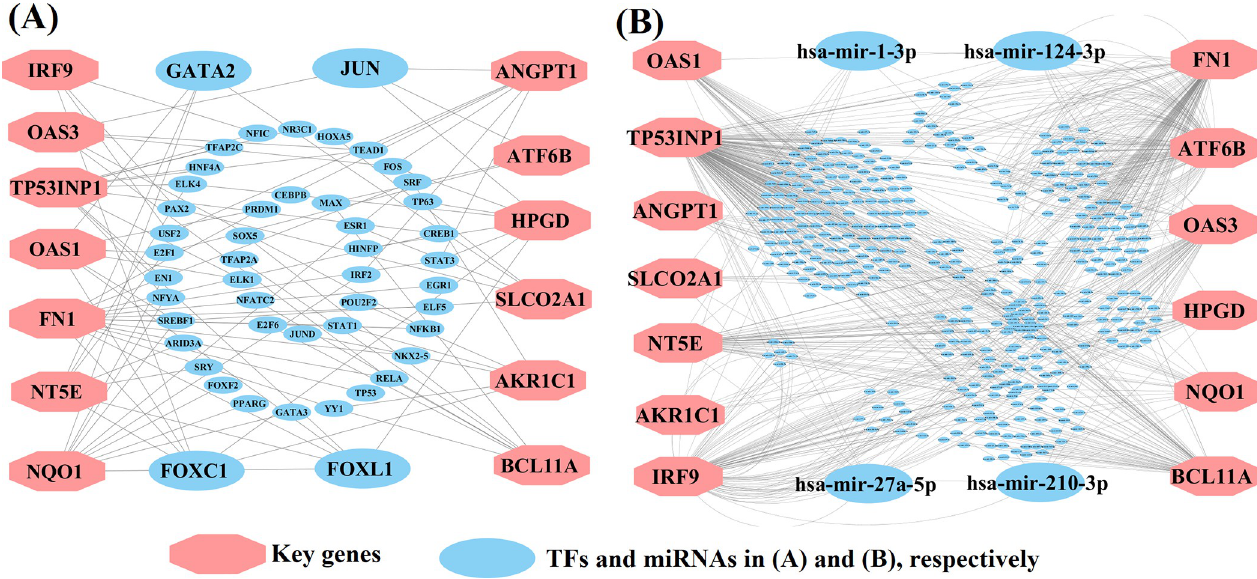
Fig 4. KGs regulatory network analysis results (A) KGs-TFs interaction network to identify key transcriptional regulators of KGs, (B) KGs-miRNAs interaction network to identify key post-transcriptional regulators of KGs. Here pink color octagon indicates the KGs in both A and B , blue color bigger size ellipse indicates key TFs in A and key miRNAs in B